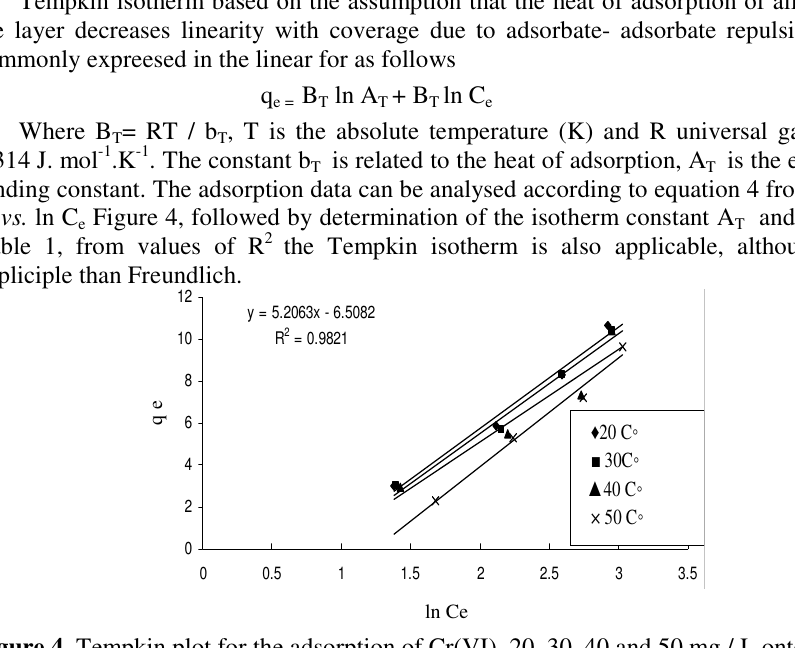
Figure 4. Tempkin plot for the adsorption of Cr(VI), 20, 30, 40 and 50 mg / L onto cinnamon 2